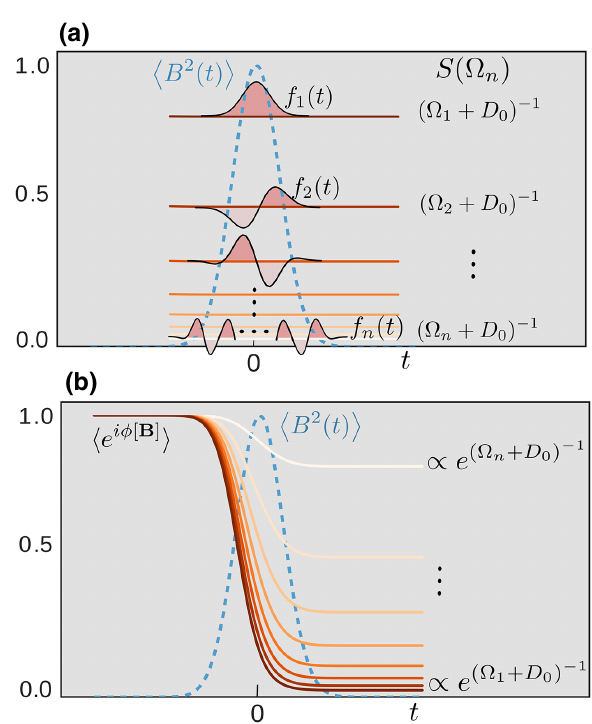
FIG. 4. Scheme for the characteristic features of a paradig- matic local-in-time, nonstationary noise that acts only near a point in time and therefore produces a discrete, generalized noise spectrum. The variance of one-dimensional noise that appears near a point in time is shown with a blue dashed line. (a) The generalized nonstationary noise spectrum S ((cid:4) n ) = 1 /((cid:4) n + D 0 ) in the noise eigenmode basis is shown with orange horizon- tal lines. The corresponding noise eigenmodes | (cid:4) n ) are shown in the time basis f n ( t ) = ( t | (cid:4) n ) for n = 0, 1, 2, . . . with